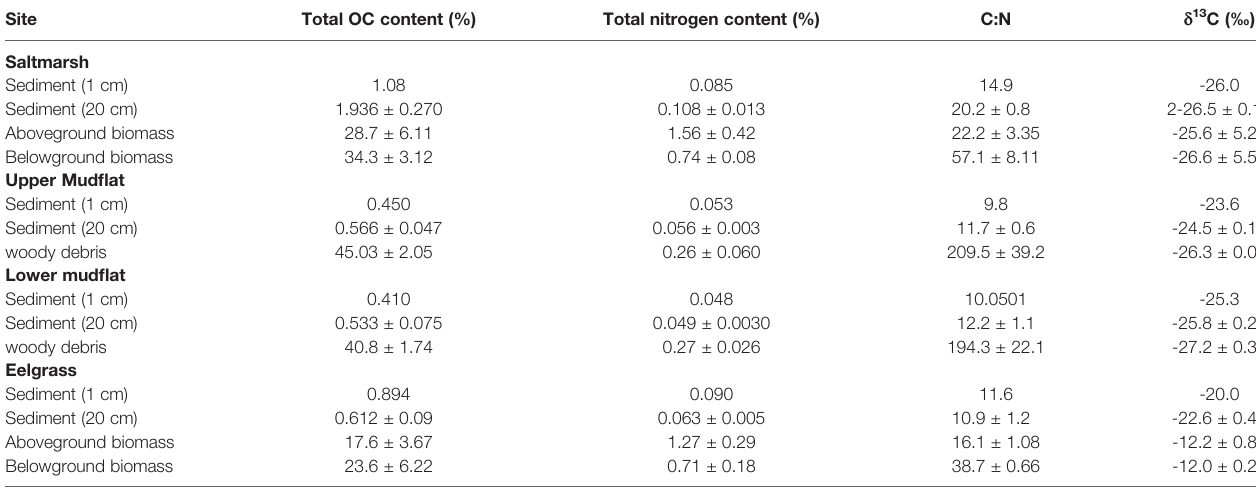
TABLE 4 | Mean organic and nitrogen contents, CLN ratio, and d 13 C signatures in biomass, surface sediment (1 cm), and top 20 cm of sediment from salt marsh, upper mud fl at, lower mud fl at, and eelgrass meadow in the Cowichan Estuary.